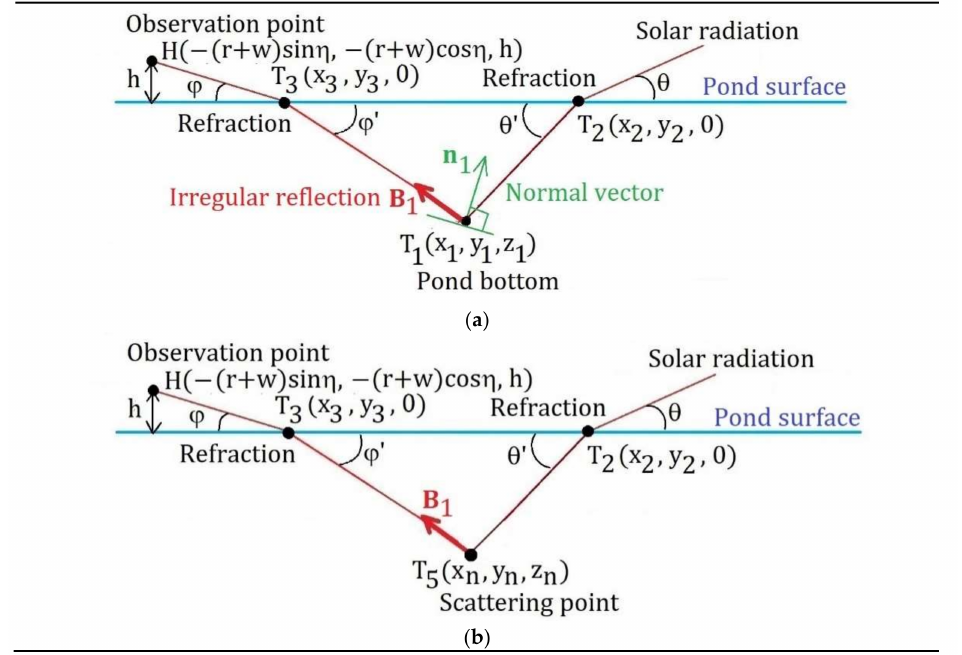
Figure 5. Optical path diagrams in the case of ( a ) irregular reflection at the pond bottom and ( b ) scattering inside the